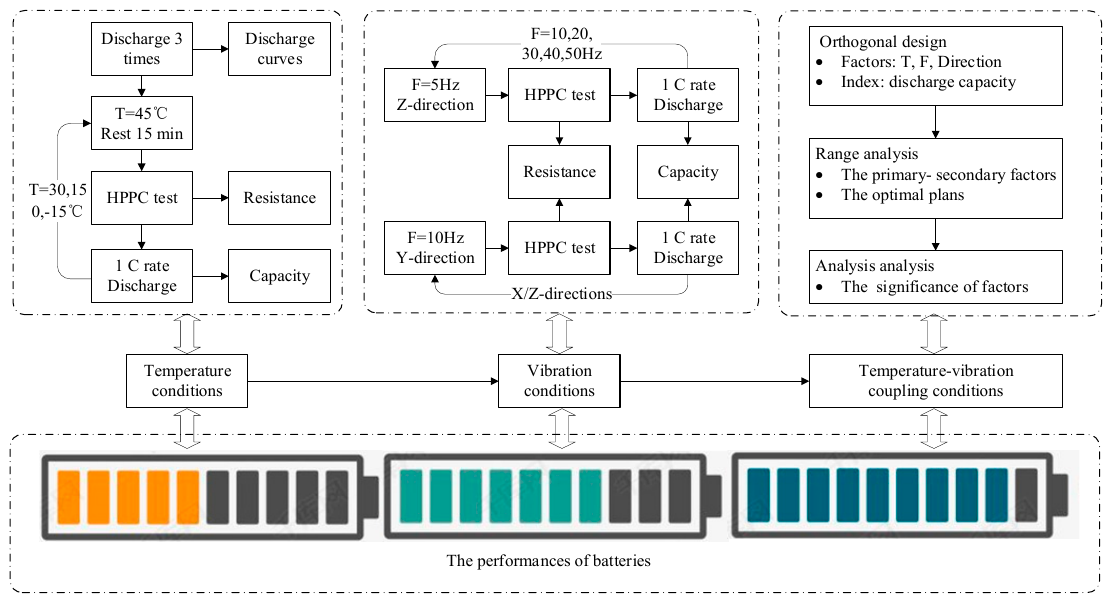
Figure 2. The method in the experiment. HPPC: hybrid pulse power characteristic.